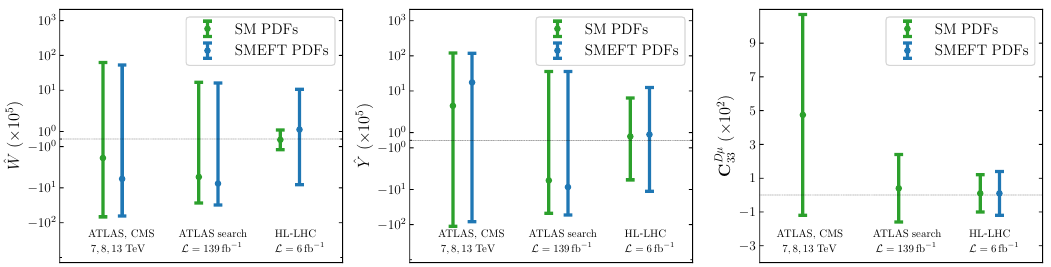
Figure 20 . Overview of the 95% CL bounds obtained in this work the EFT parameters ˆ W (left), ˆ Y (middle), and C Dµ (right panel) based on either the SM PDFs of the SMEFT PDFs. Both PDF 33 and methodological uncertainties are accounted in the bounds, when